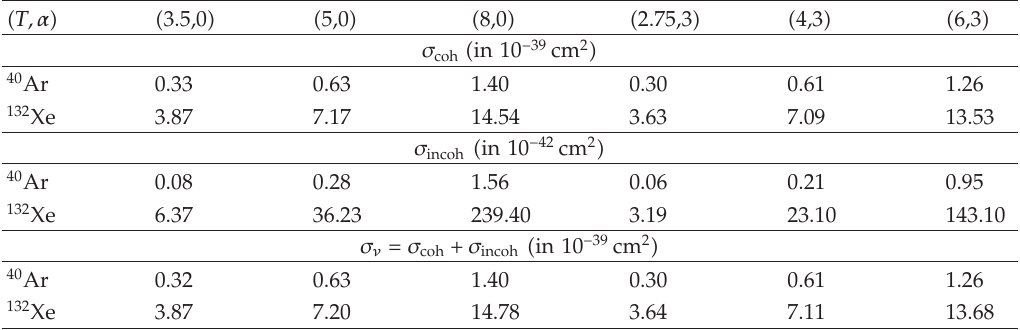
Table 4: Coherent, incoherent, and total (cid:3) coherent plus incoherent (cid:4) neutrino nucleus cross section for 40 Ar and 132 Xe targets.The supernova neutrino spectra described by a two-parameter Fermi-Dirac distribution with α (cid:8) 0 and 3 for various temperatures T (cid:3) MeV (cid:4) .